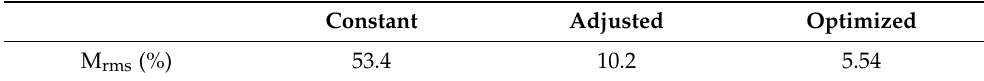
Table 3. RMS of NH 3 /NO molar ratio at the inlet of the catalyst layer for the upper-skewed profile.